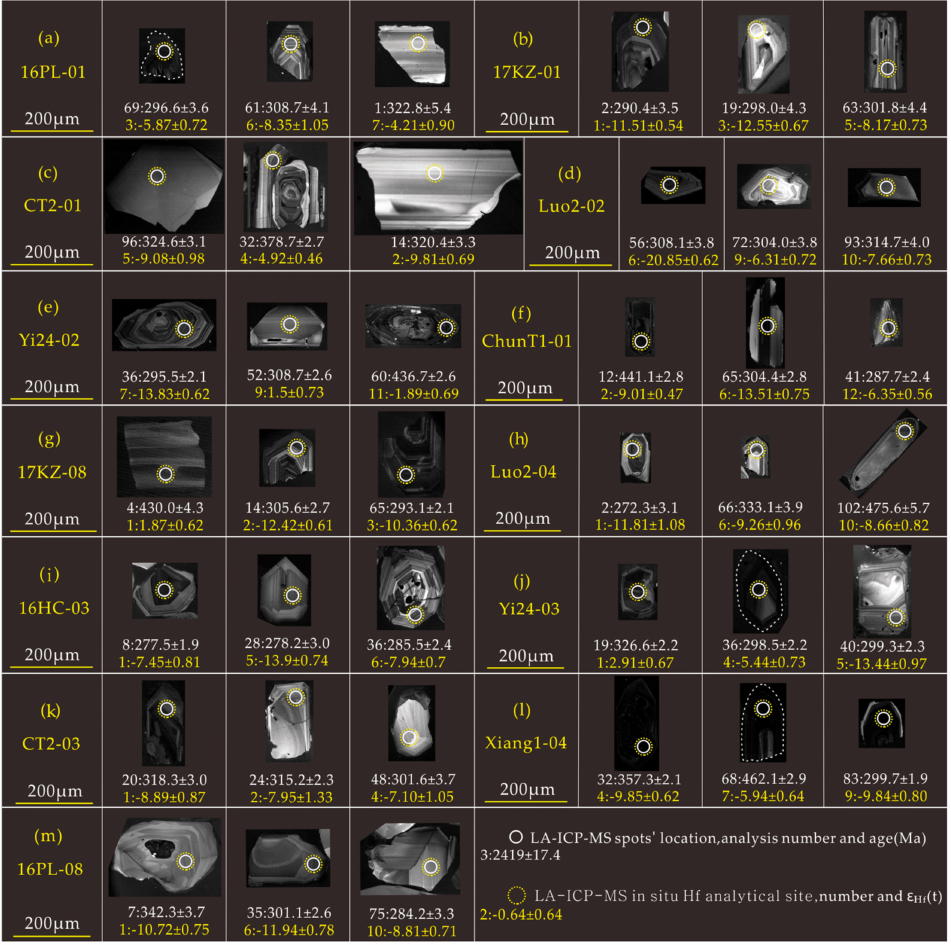
Figure 6. Representative cathodoluminescence (CL) images of the zircons from all samples.